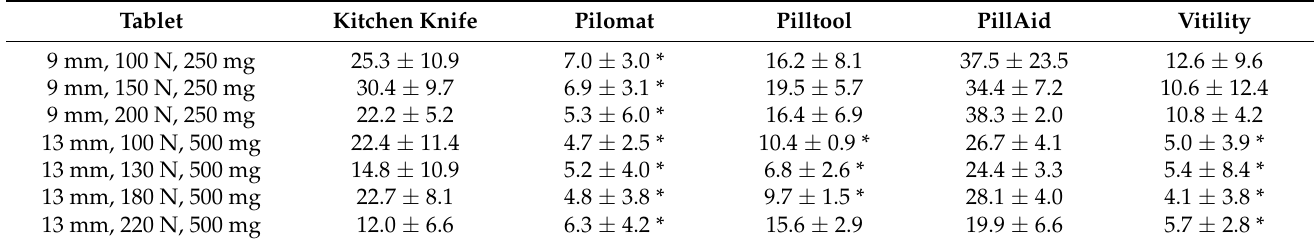
Table 2. Performance of tablet splitters. Given is the mean difference (%) of two split parts relative to the calculated weight of a half tablet ± standard deviation ( n = 6 for each tablet